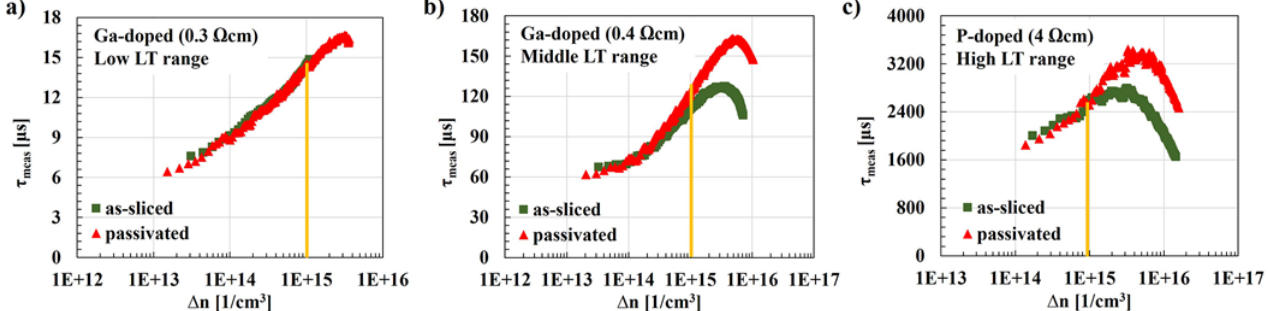
Fig. 7. Effective lifetime measured on as-sliced surface approaches the lifetime from surface passivated Cz-mono silicon slabs. The higher the lifetime, the longer the time needed to approach. At standard excess carrier density D n =10 15 cm (cid:1) 3 (marked with yellow lines) and below the difference is under 20% in both low- (a), middle- (b) and high (c) lifetime cases. During the measurement the excess carrier density decreases, so the time passes from right to left on the